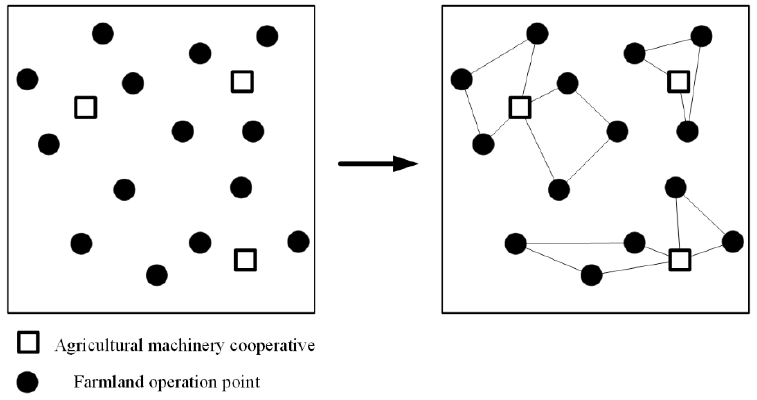
Figure 3. Schematic diagram of solving agricultural machinery scheduling problem.